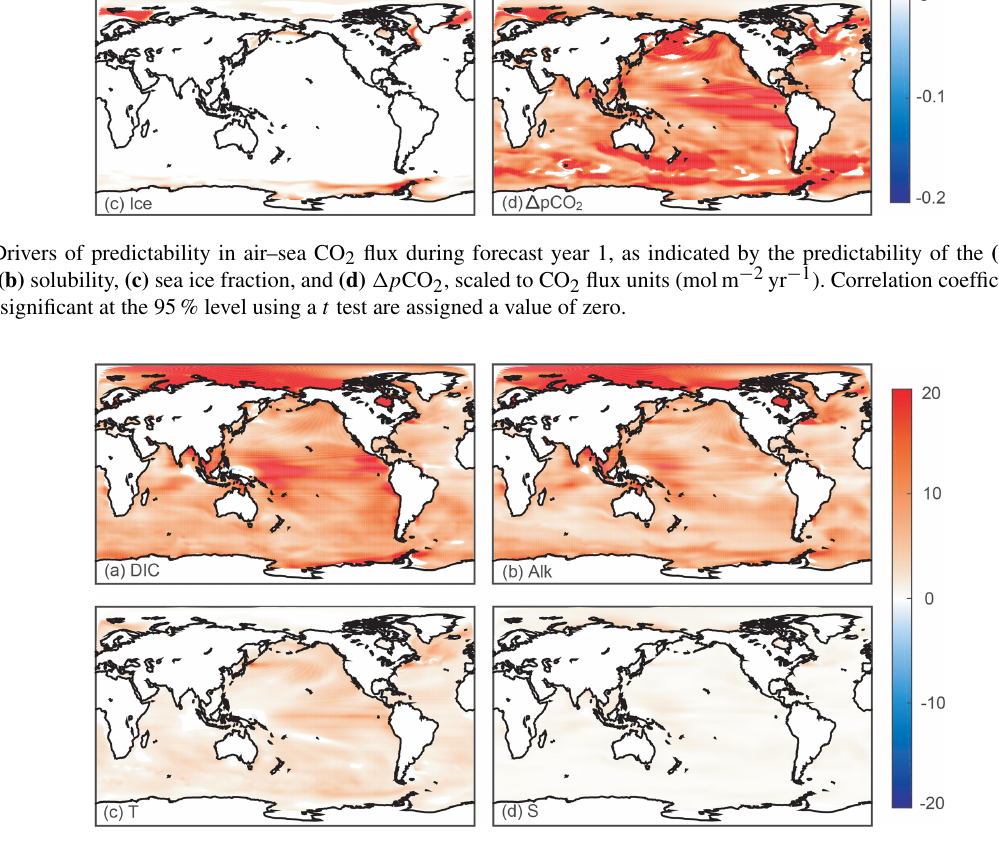
Figure 6. Drivers of predictability in surface ocean p CO 2 during forecast year 1, as indicated by the predictability of surface ocean (a) DIC, (b) Alk, (c) temperature, and (d) salinity, scaled to p CO 2 units (µatm). Correlation coefficients that are not statistically significant at the 95% level using a t test are assigned a value of